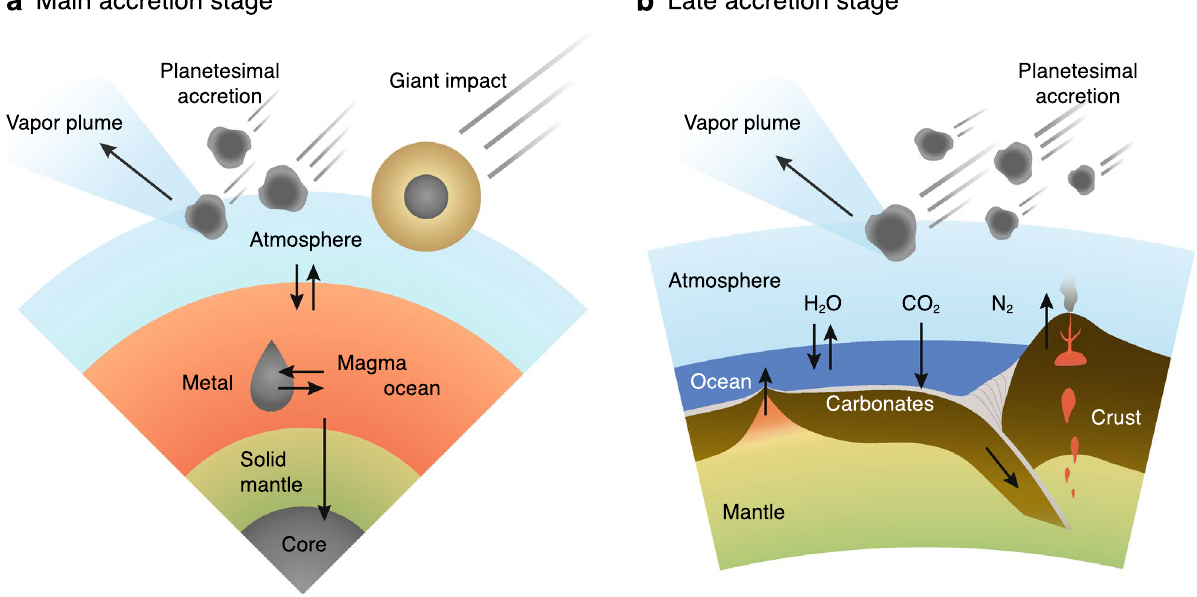
Figure 1. Cartoon of element partitioning processes during Earth’s accretion according to our model. Accreting planetesimals and giant impactors deliver volatiles and simultaneously form a vapour plume eroding the atmosphere. ( a ) Model for the main accretion stage (10% to 99.5% of the Earth’s mass). Equilibration among the magma ocean (silicate melt), liquid metal droplets transiting to the core, and the overlying atmosphere are achieved according to each metal silicate partitioning coefficient and solubility. ( b ) Model for the late accretion stage after the solidification of the magma ocean (the last 0.5%). We consider the liquid water oceans and the carbonate-silicate cycle to be driven by plate tectonics on the surface. In this stage, most H and C on Earth are stored in the oceans and carbonate rocks, respectively. Numerous impactors can selectively erode